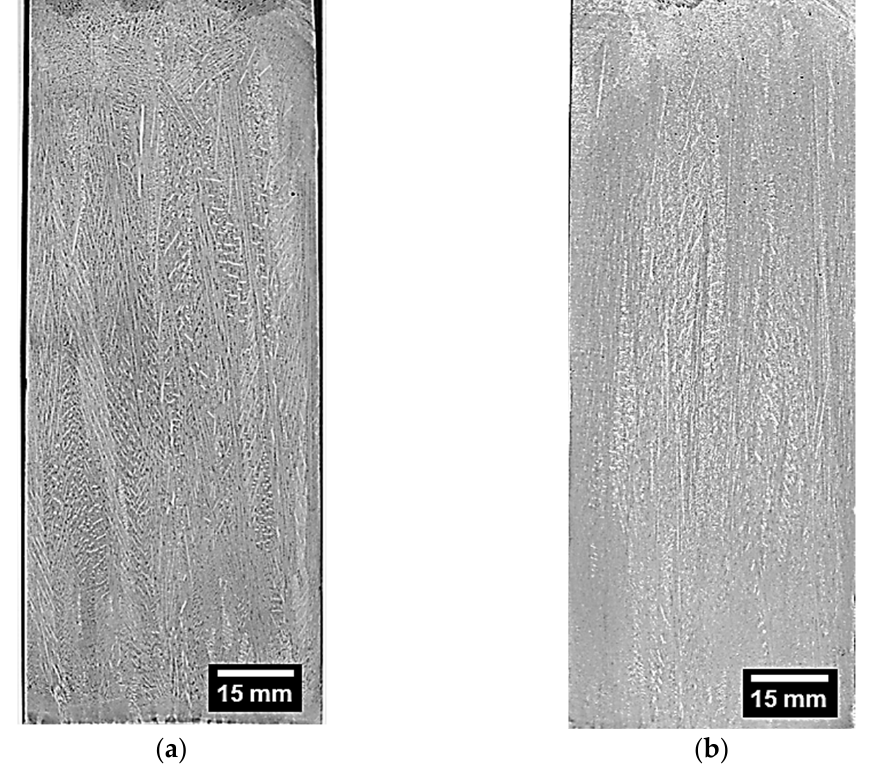
Figure 4. Columnar-type grain morphology revealed along the longitudinal section of the evaluated ( a ) Al-10 wt.% Si-0.45 wt.% Mg and ( b ) Al-10 wt.% Si-1 wt.% Mg alloys.